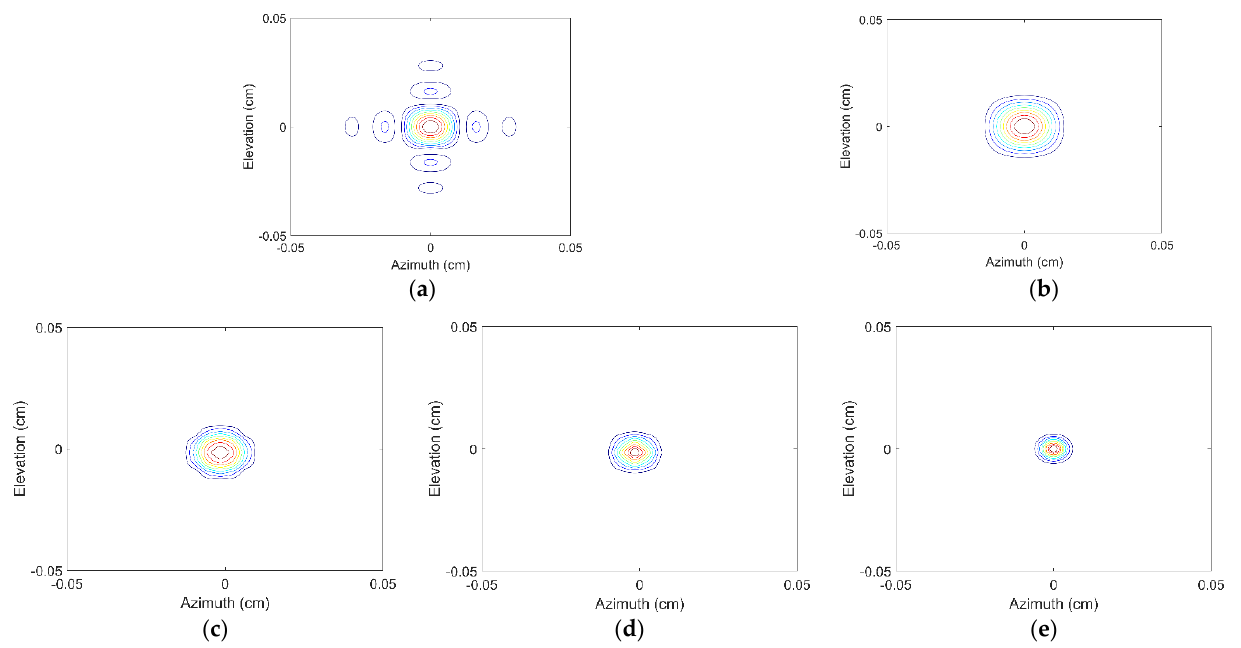
Figure 6. Azimuth − elevation images at range 0 m by ( a ) 3D IFFT without windowing, ( b ) 3D IFFT with windowing, ( c ) BPDN, ( d ) SR-CNN, ( e ) Ground − truth.